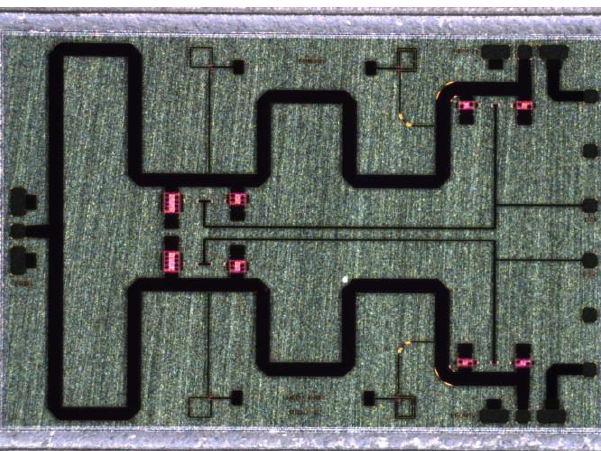
Figure 22: Die photo of the switch